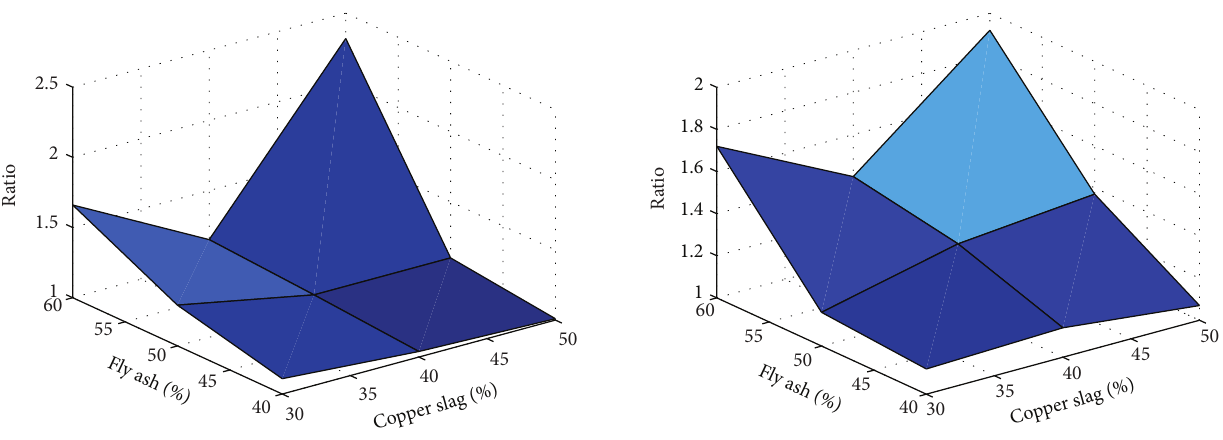
Figure 14: Results of experiment with steel fibres.